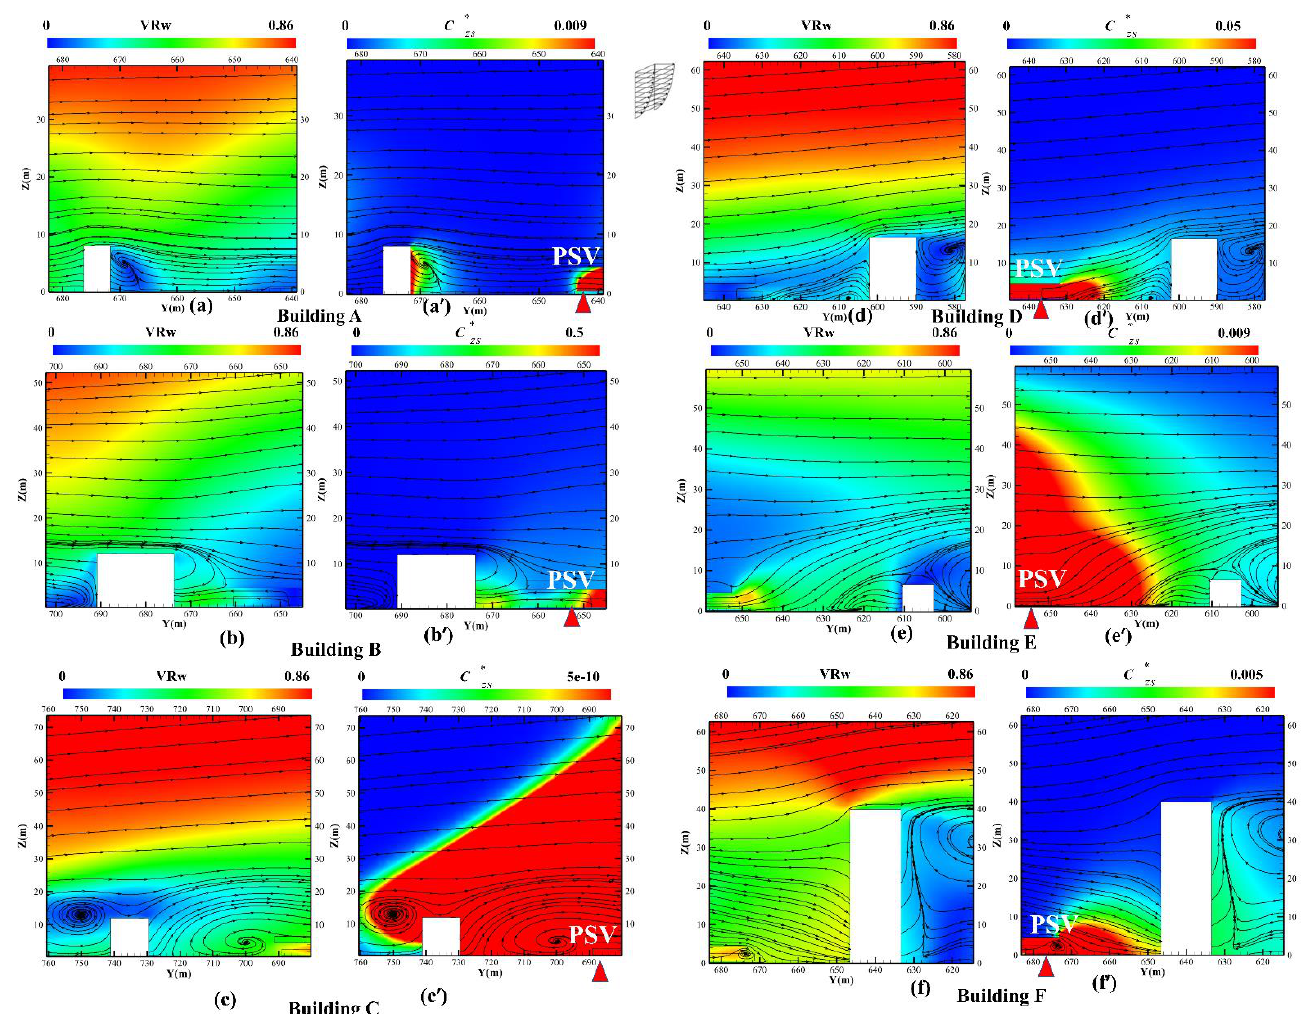
Figure 14. ( a − f ) Contours of spatially – averaged wind velocity ratio (VR w ) and streamlines. ( a ′ − f ′ ) Normalized pollutant concentration ( C *) and streamlines in the symmetry plane of the domain.